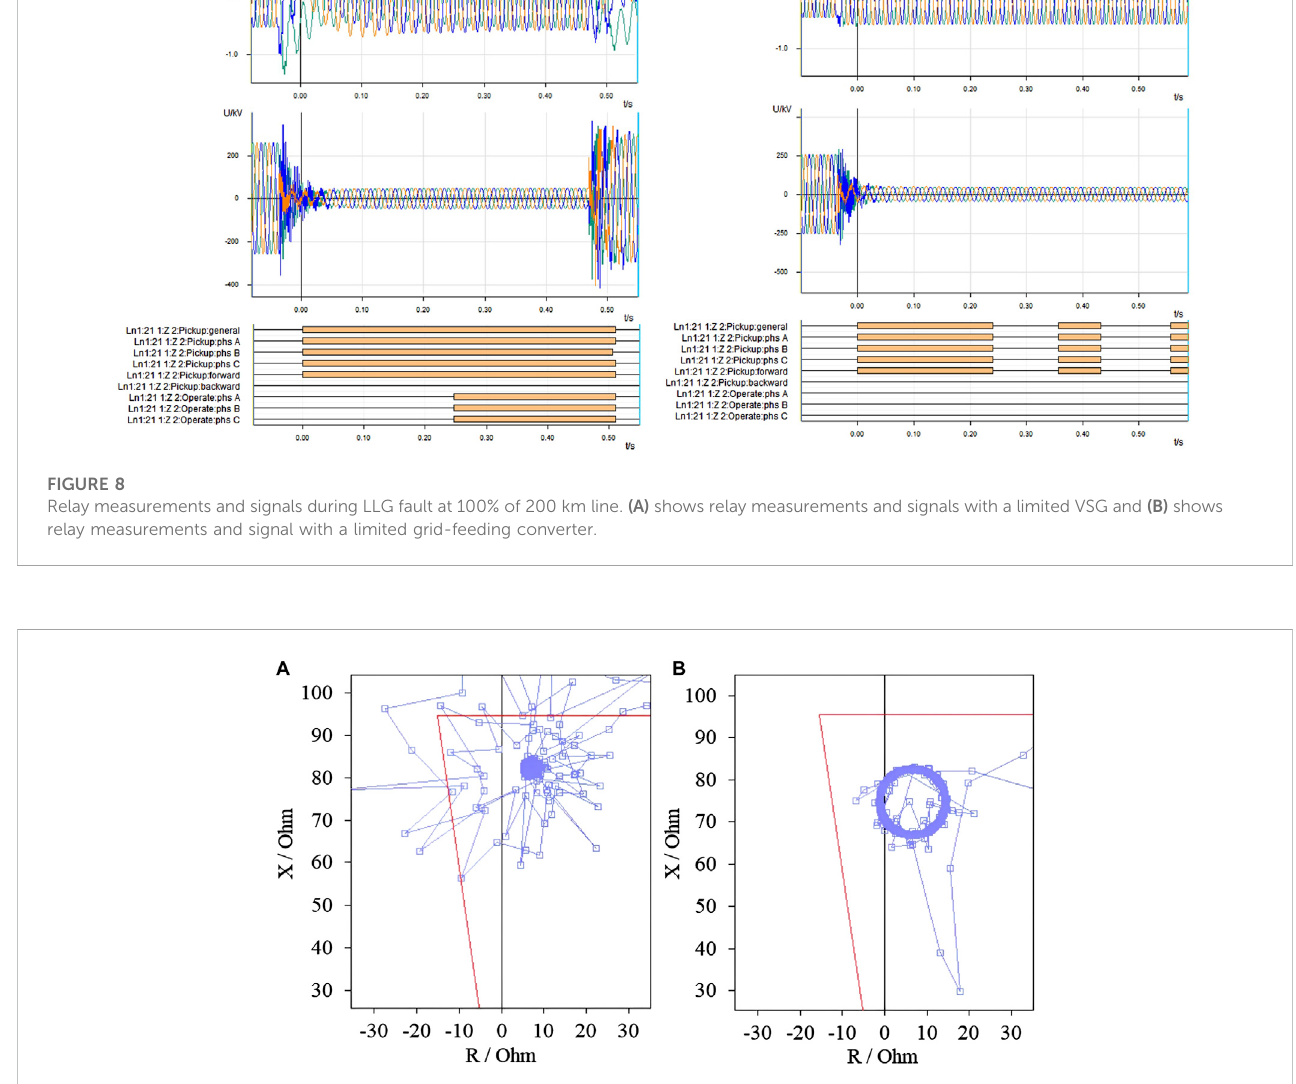
FIGURE 9 Relay impedance measurements during the fault. Blue line shows the impedance locus measurement and red polygon represents the distance protection zone 2 characteristic. (A) shows relay measurement with a limited grid-forming converter and (B) shows relay measurement with a grid feeding